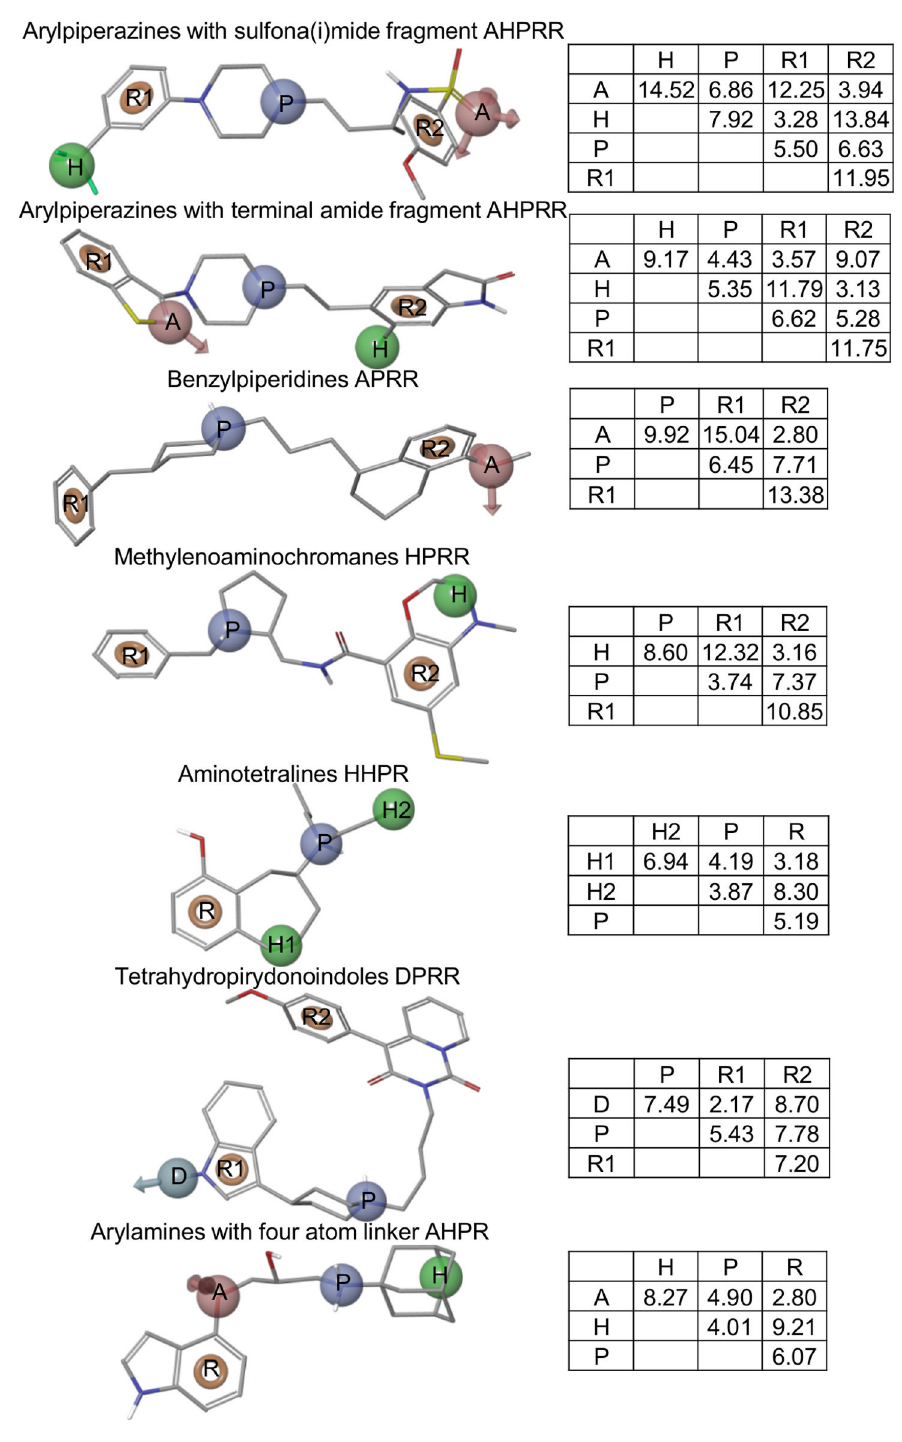
Figure 9. The best linear combination of pharmacophore models obtained for manual clustering and MCC optimization. The best linear combination of pharmacophore models obtained for manual clustering and MCC optimization (manual/random/hit-once; see also Figures 4 and 6). For each hypothesis the best fitting compound is presented, along with a matrix of distances (in angstroms) between features and a name of cluster it was developed on. The feature abbreviations used are: hydrogen bond acceptor – A , hydrogen bond donor – D , hydrophobic group – H , positively charged group – P , aromatic ring – R .